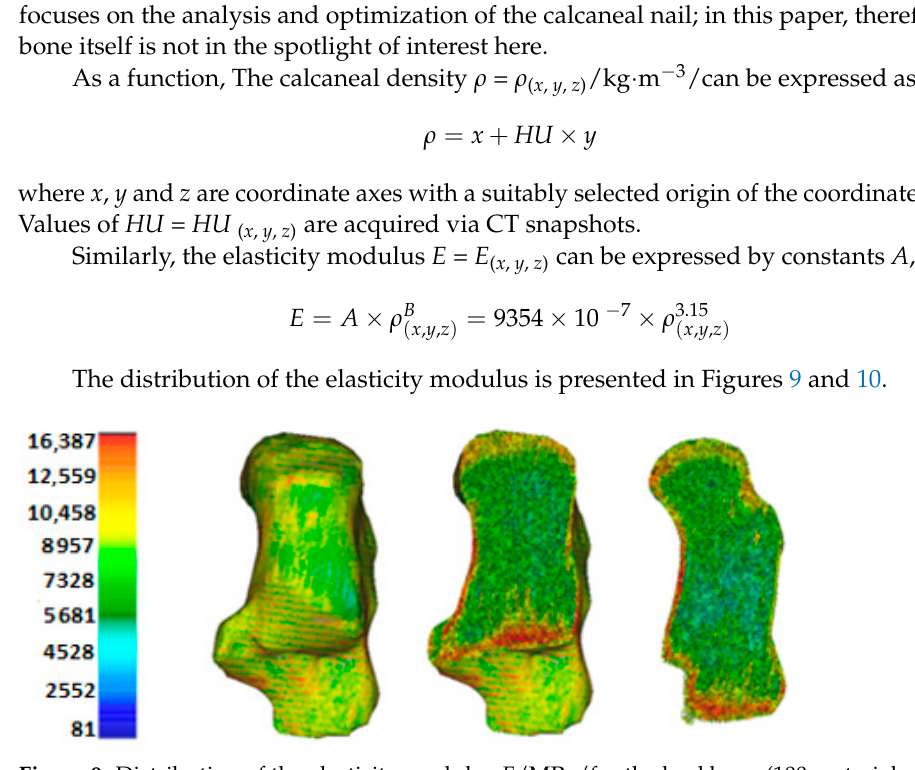
Figure 8. Association of the elasticity modulus and Hounsfield units.